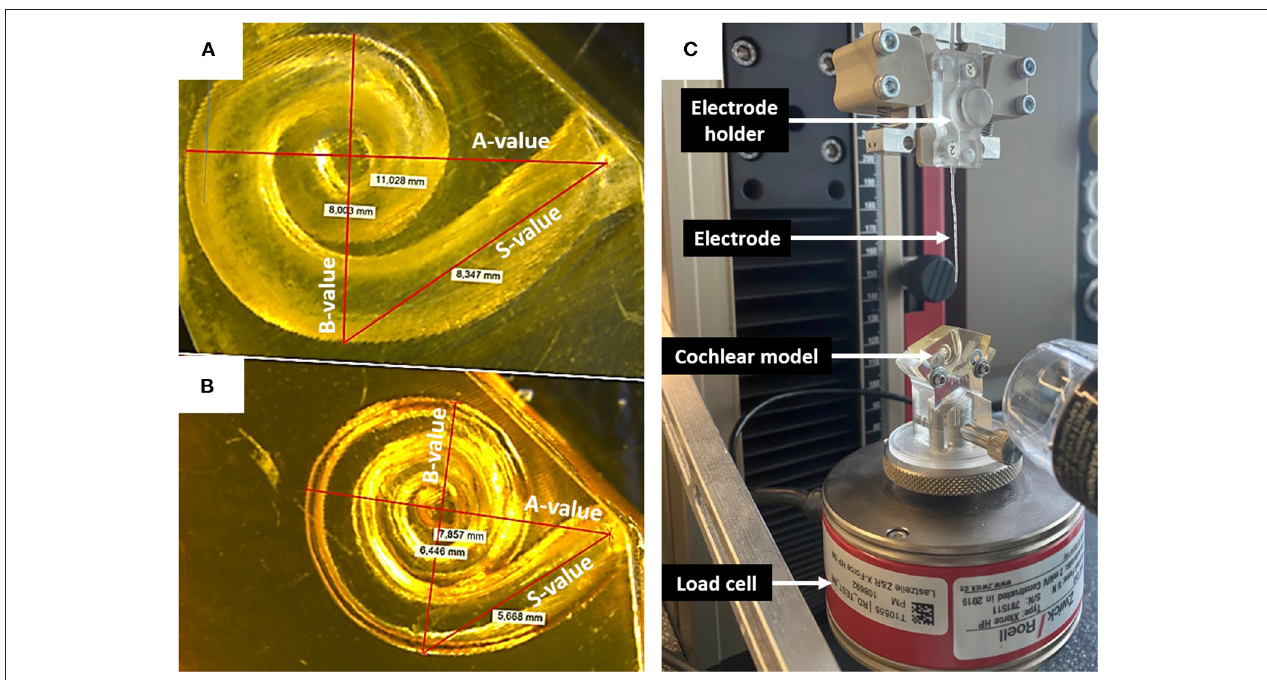
FIGURE 3 | (A) Upscaled ST model: A-value 11mm; B-value 8mm; S-value 8.3mm. (B) Small ST model: A-value 7.9mm; B-value 6.4; S-value 5.6mm. (C) Electrode insertion force measurement test set-up.